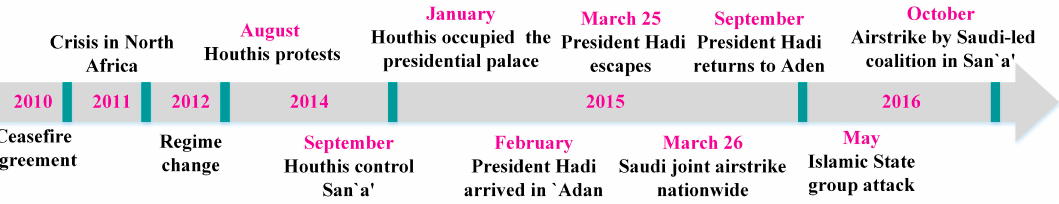
Figure 1. An administrative map of Yemen.